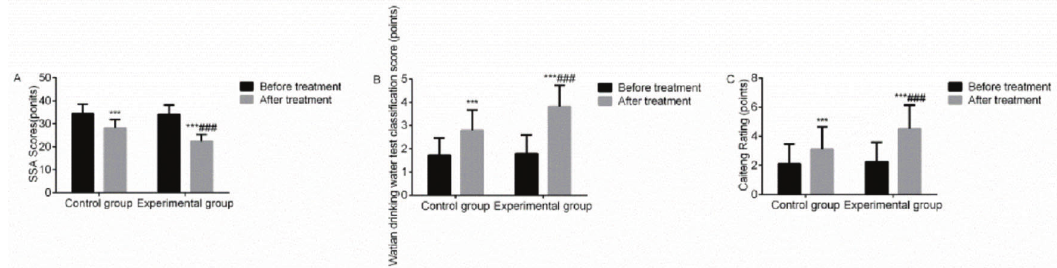
Figure 2 - Comparison of the SSA scores, grading scores of the Kubota drinking water test, and Caiteng grading scores between the two groups before and after treatment. Note: compared with the group before treatment, *** p o 0.001; compared with the control group, ### p o